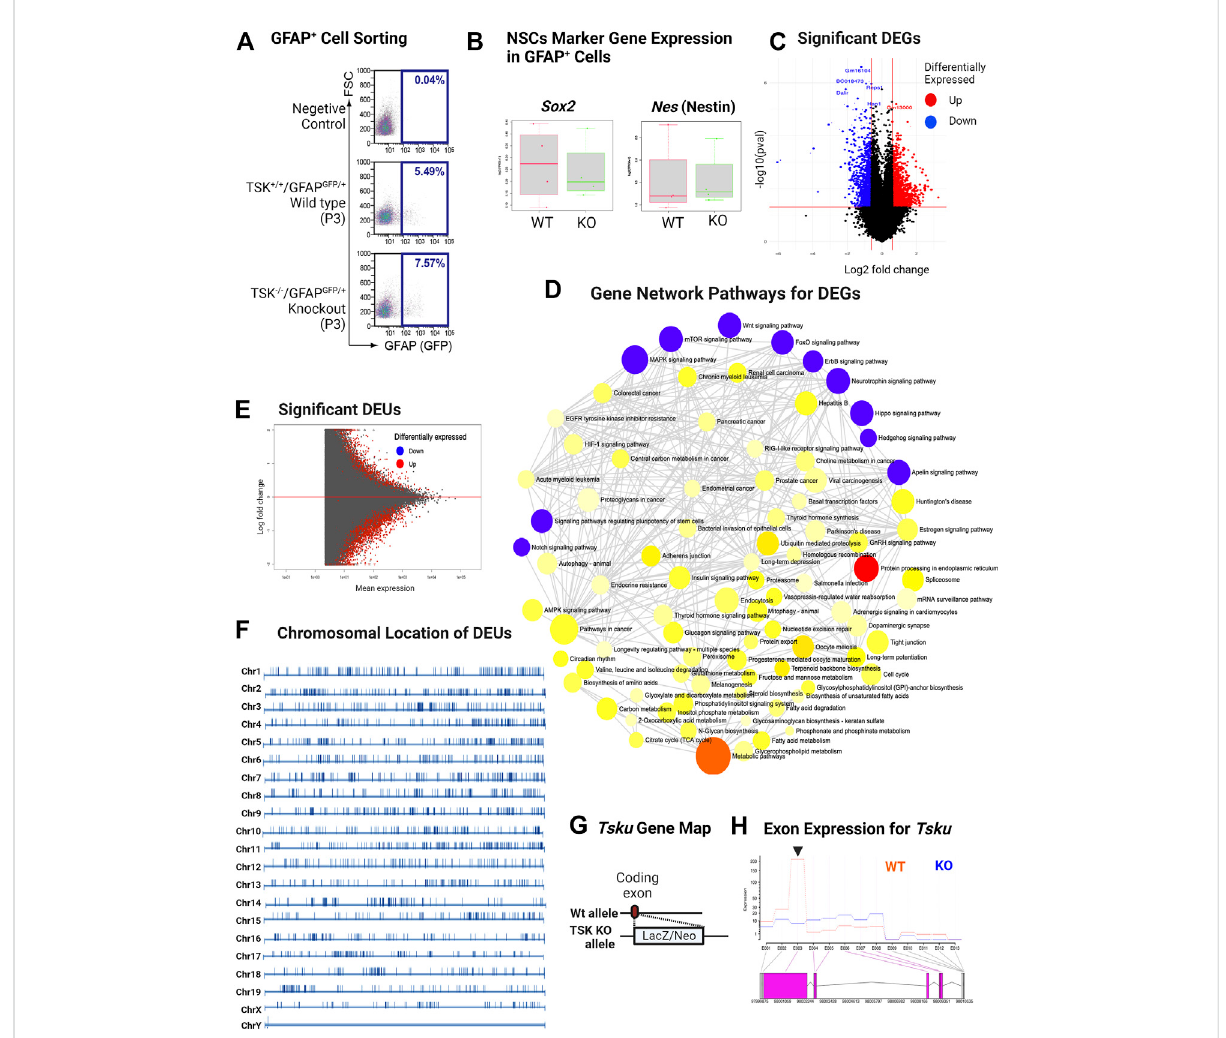
FIGURE 3 KO GFAP+ cells exhibit differential gene expression in multiple developmental pathways and genome-wide missplicing of coding genes. (A) RepresentativeimageofsortingofGFAP GFP+ cellsbyFACS. (B) FPKMdistributionof Sox2 and Nes NSCmarkersinWTandKOgroups. (C) Volcanoplot ofdifferentiallyexpressed genes. Geneswithsigni fi cant( p < 0.05)increase anddecreaseintheir expression arecoloredinredand blue,respectively. (D) Gene-set enrichment network of differentially expressedgenes using signi fi cantly enriched KEGG pathway functional categories ( p < 0.05). The nodes represent enriched pathway gene sets. The size of the node is proportional to the number of relevant genes in the set. The p -value of the node is indicated by the yellow to red gradient. Essential developmental signaling pathways are indicated by blue colored nodes (irrespective of p -value). Edges (gray lines) indicate shared genes between two nodes. (E) MA plot for signi fi cant differential exon usage between the wild-type and knock-out groups. Signi fi cant hits at FDR = 0.1 are colored in red. (F) Chromosomal distribution of signi fi cant DEU-coding genes. The position of DEU genes is marked by vertical bars. The scale differs for each chromosome. (G) Schematic of TSK KO generation by allelic insertion of LacZ/Neo cassette in the coding exon. (H) Expression of Tsku exons in WT vs. KO. Data shown as Fitted expression plot. Pink indicates the signi fi cant differentially expressed coding exon. Arrowhead indicates the coding exon of Tsku (Targets for LacZ/Neo cassette insertion). The data presented here was generated by comparing four biological replicates from the WT and KO